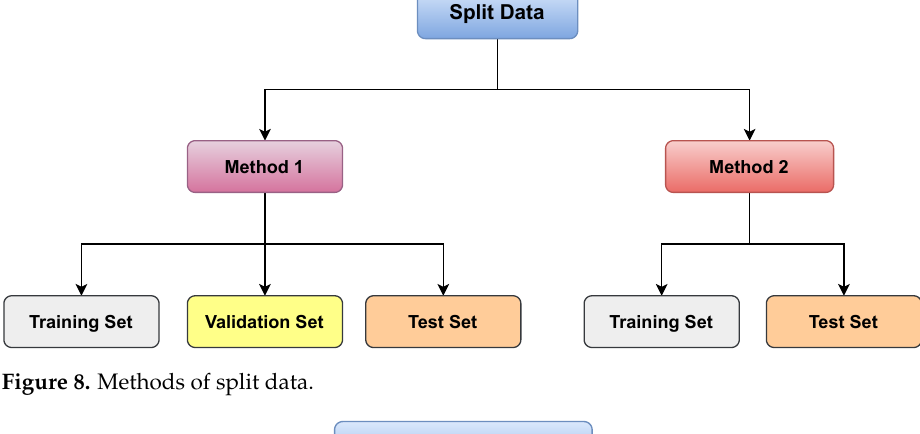
Figure 8. Methods of split data.